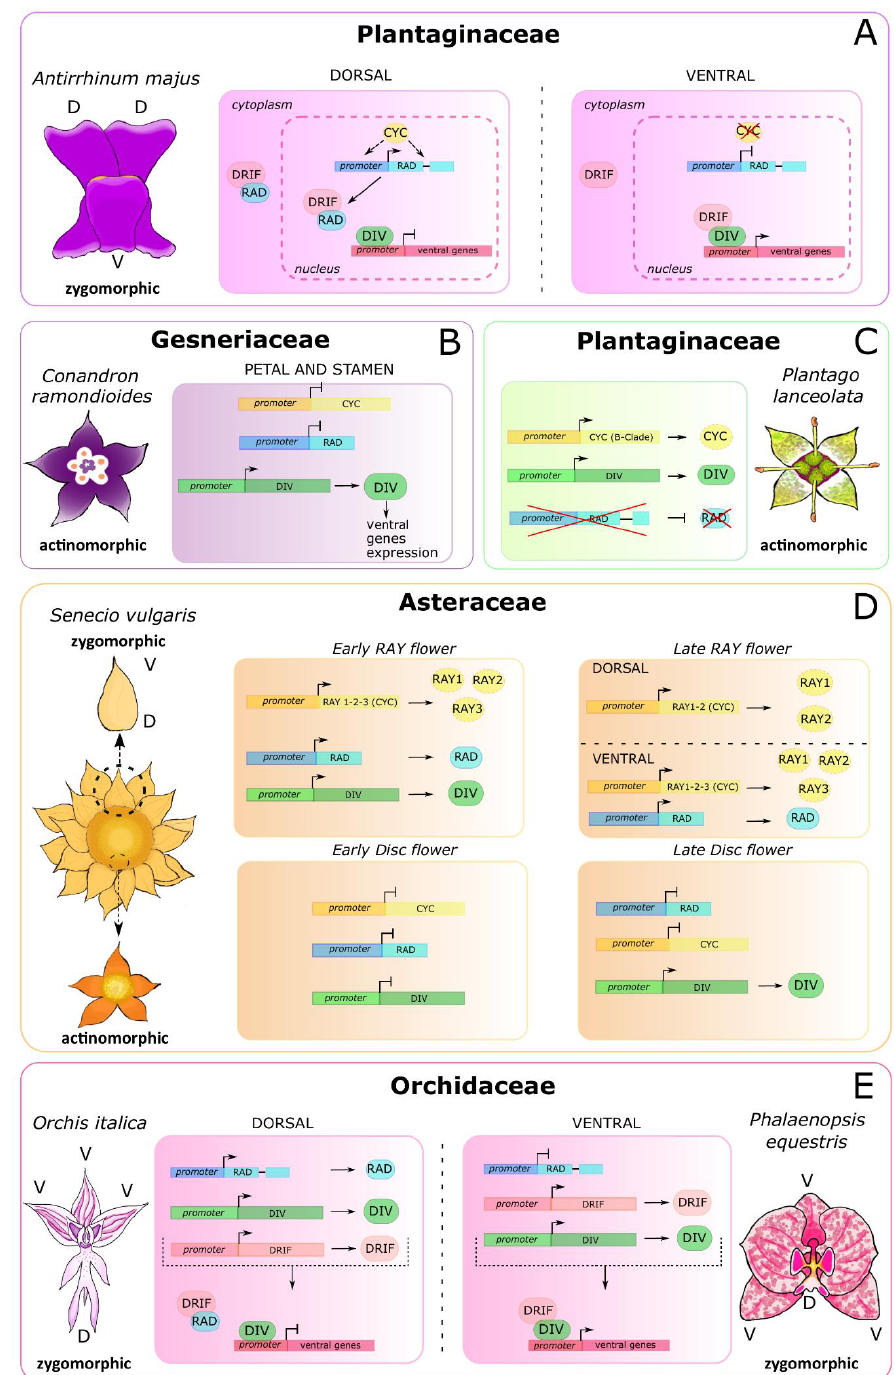
Figure 4. Molecular models explaining the establishment of floral symmetry in di ff erent plant families. The key factors belong to the TCP (CYC) and MYB (DIV, DRIF, RAD) TF families. The molecular pathways established in di ff erent species vary in relation to the symmetry type of the flower. Within the Plantaginaceae family, two examples illustrate the regulative network when the flower has dorsoventral asymmetry ( A , A. majus ) or radial symmetry ( C , P. lanceolata ). B ) The molecular pathway that drives the radial symmetry of the Conandron ramondioides flower (Gesneriaceae). D ) The complex symmetry of the ray and disc florets within the capitulum of Senecio vulgaris (Asteraceae). E ) The bilateral flower of orchids (Orchidaceae). As a consequence of the resupination, the model is rotated of 180 ◦ with respect to that of A. majus